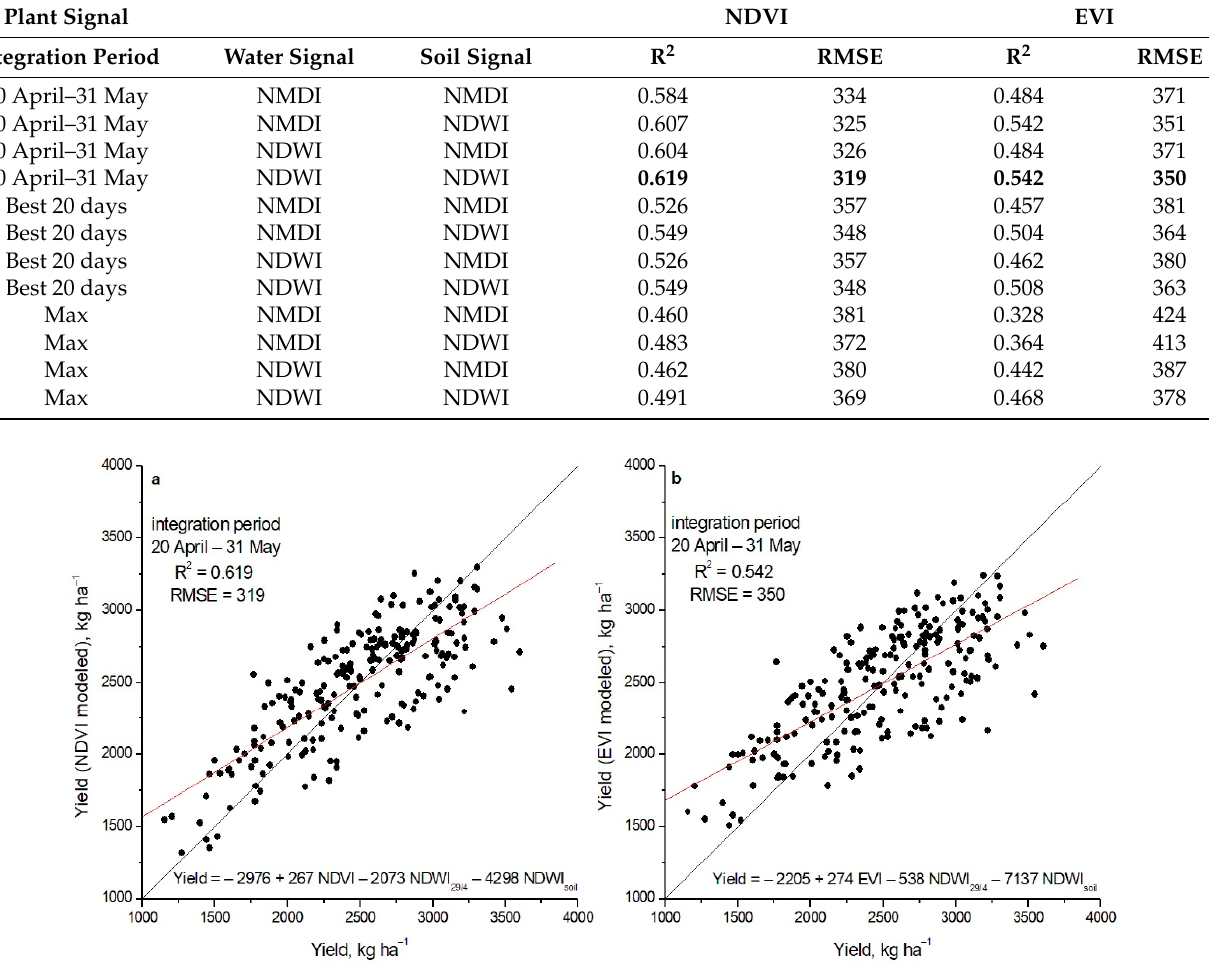
Table 3. Coefficients of determination (R 2 ) and root mean square error (RMSE, kg ha − 1 ) between measured final yield and various model versions incorporating different plant, water, and soil signals. Best 20 days integral concerns the 6–25 May period. Data concern the pilot field, corresponding to 221 pixels. The most significant correlations are indicated in bold. Plant Signal NDVI EVI